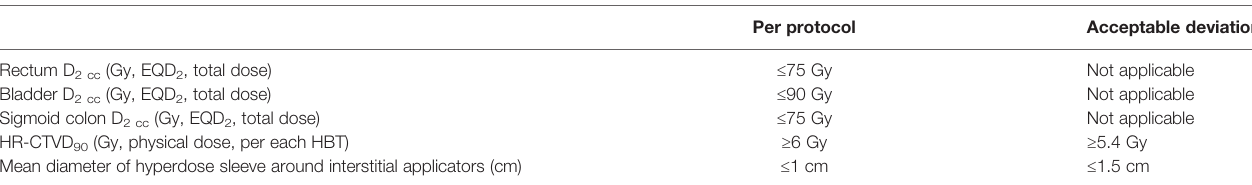
TABLE 1 | Dose constraints of HBT plus